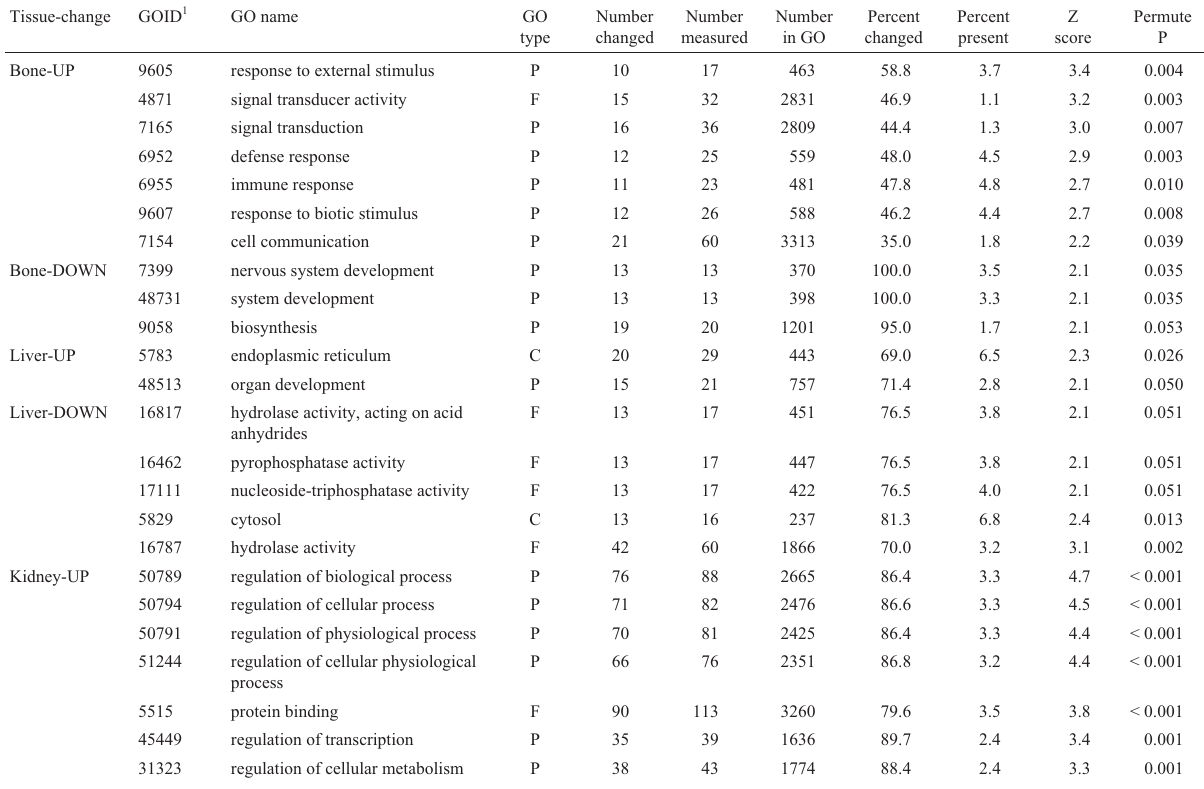
Table 3 - Gene Ontology biological profiling of different tissues in sfx mice.